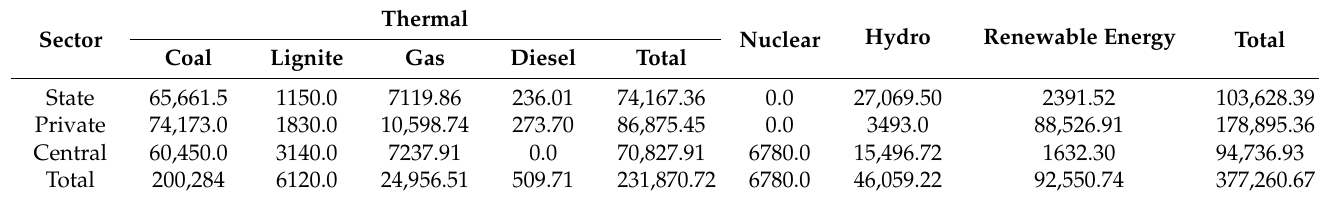
Table 10. Power scenarios (MW) by resource and sector, as on 31 March 2021. Source: Central Electricity Authority, Government of India